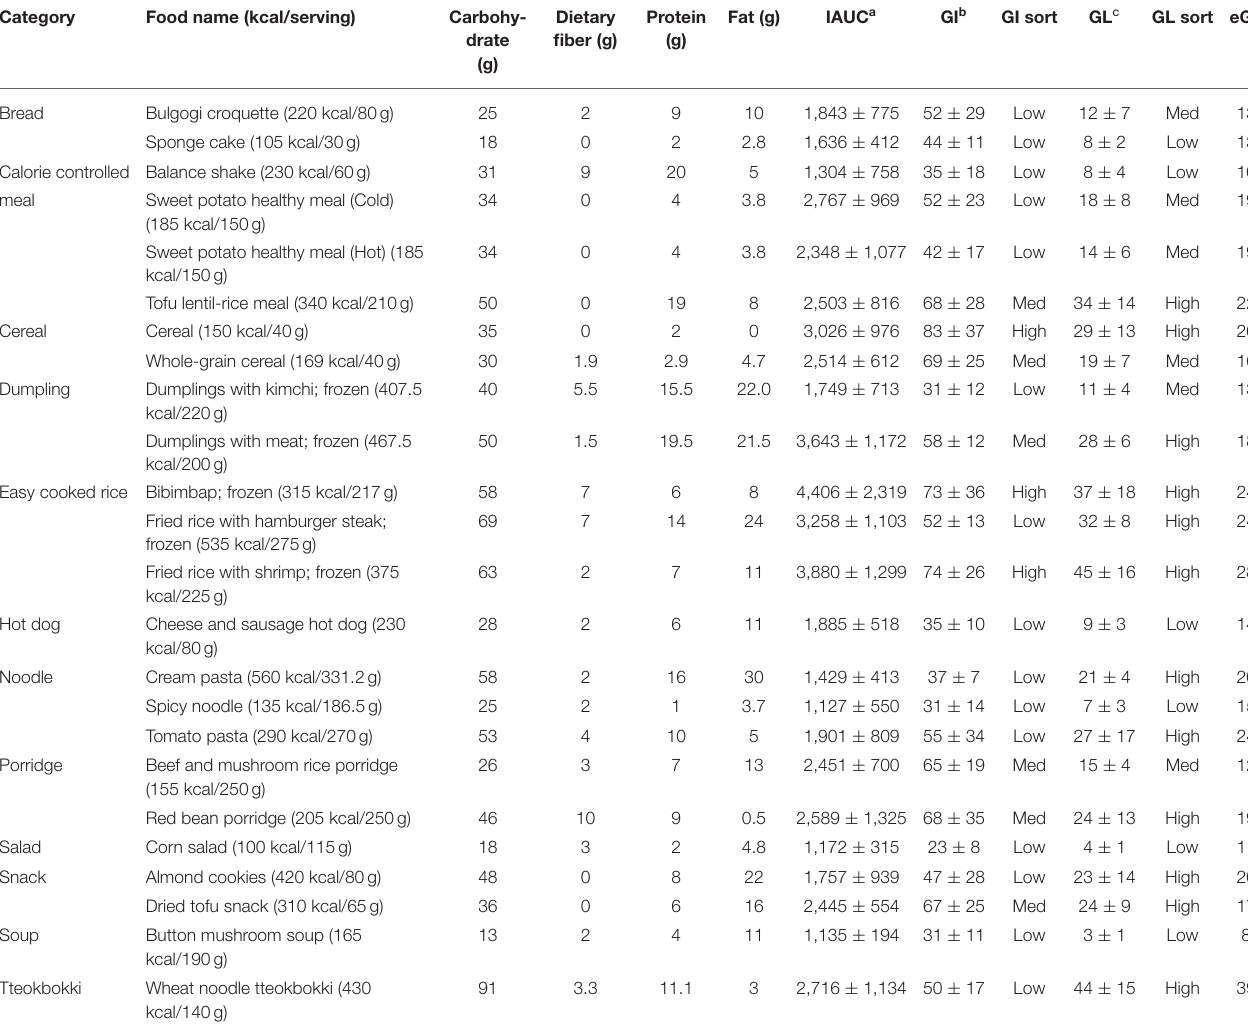
Values of IAUC, GI, GL represent M ± SD. a Incremental area under the blood glucose response curve. b Glycemic index. c Glycemic